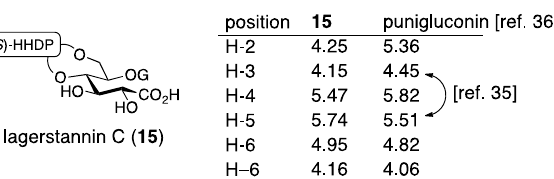
Figure 8. The comparison of the 1 H-NMR chemical shifts between lagerstannin C ( 15 ) and punigluconin.